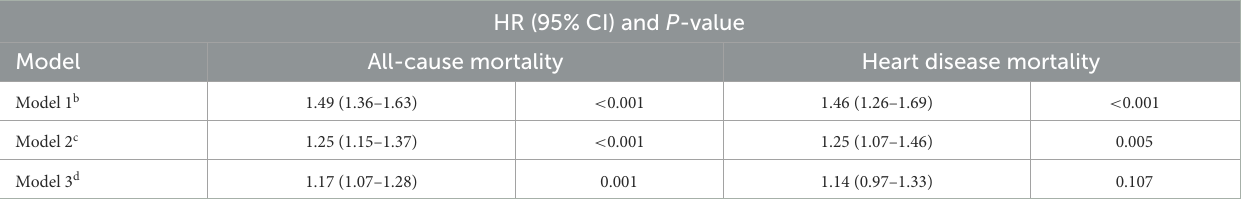
TABLE 2 Association of sleep complaints with all-cause and heart disease mortality among all participants a .